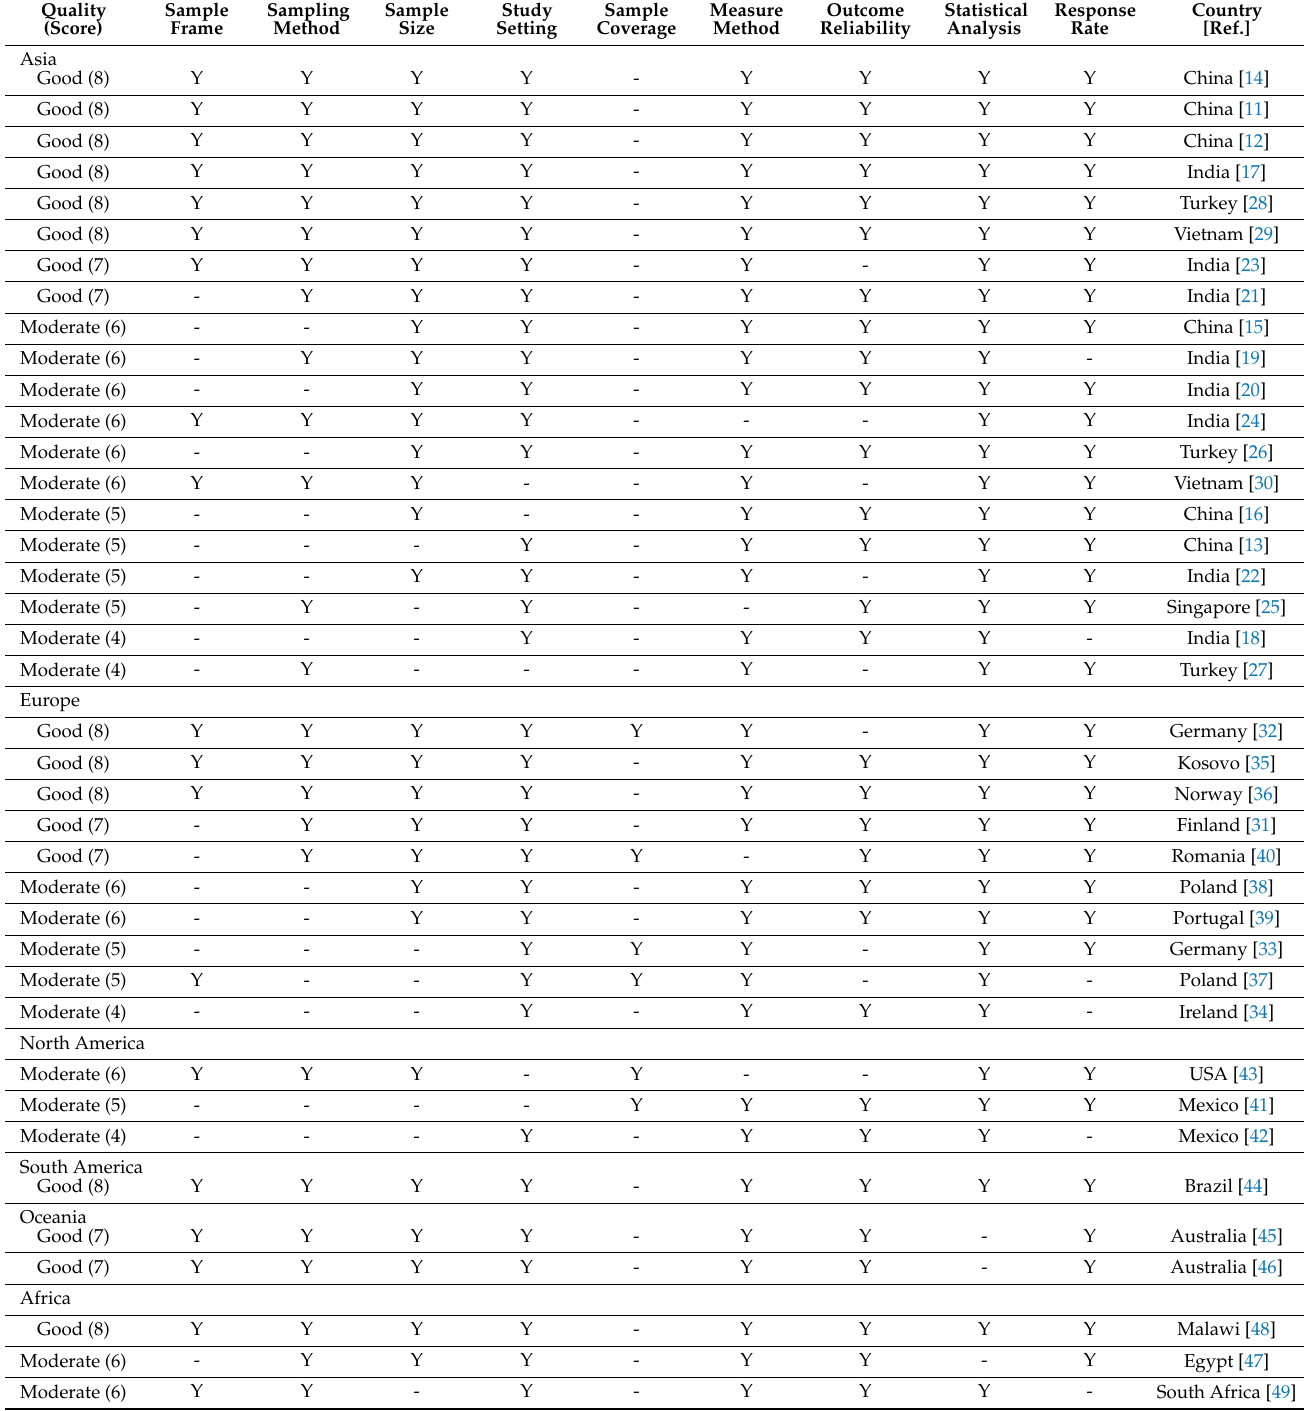
Table 6. Quality assessment of the studies by